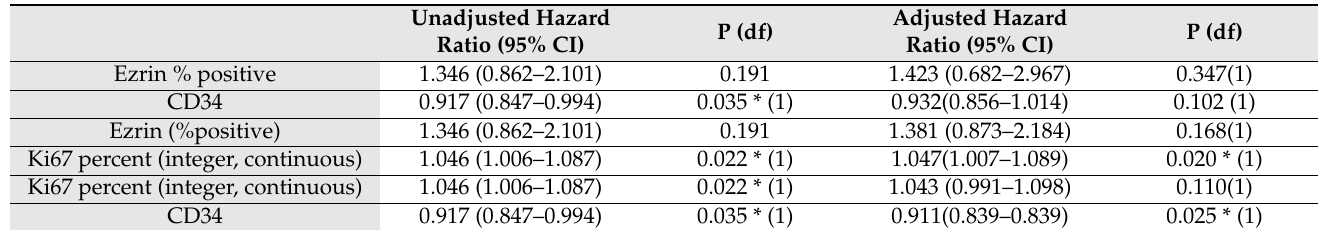
Table 5. Predictors of melanoma-specific mortality from three multiple regression Cox survival models in the melanoma cancer patient sample. * Denotes a significant p value of